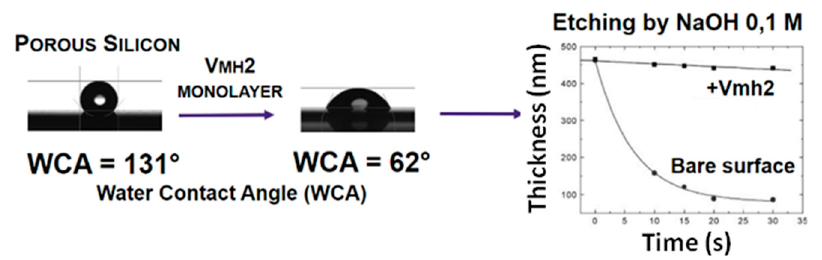
Figure 1. Change of wettability of PSi by Vmh2 and variation of PSi thickness with time, showing protection from etching by Vmh2.